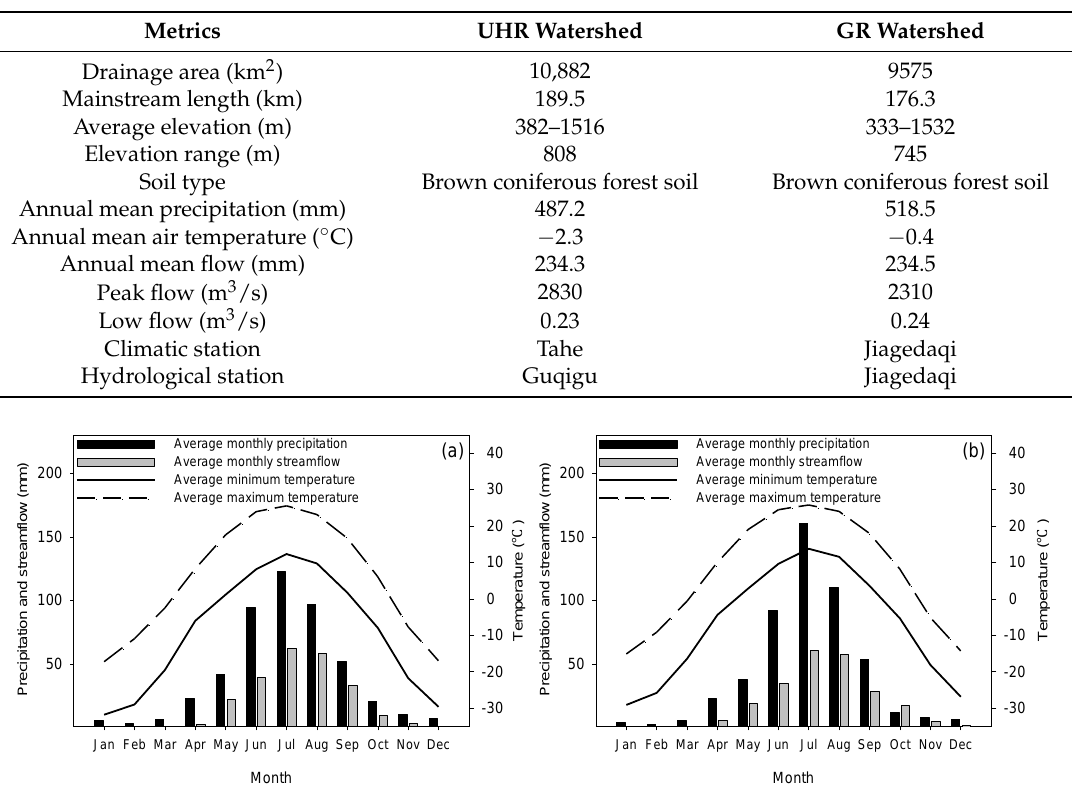
Table 1. watershed characteristics for the Upper Huma River (UHR) and Ganhe River (GR) watersheds.